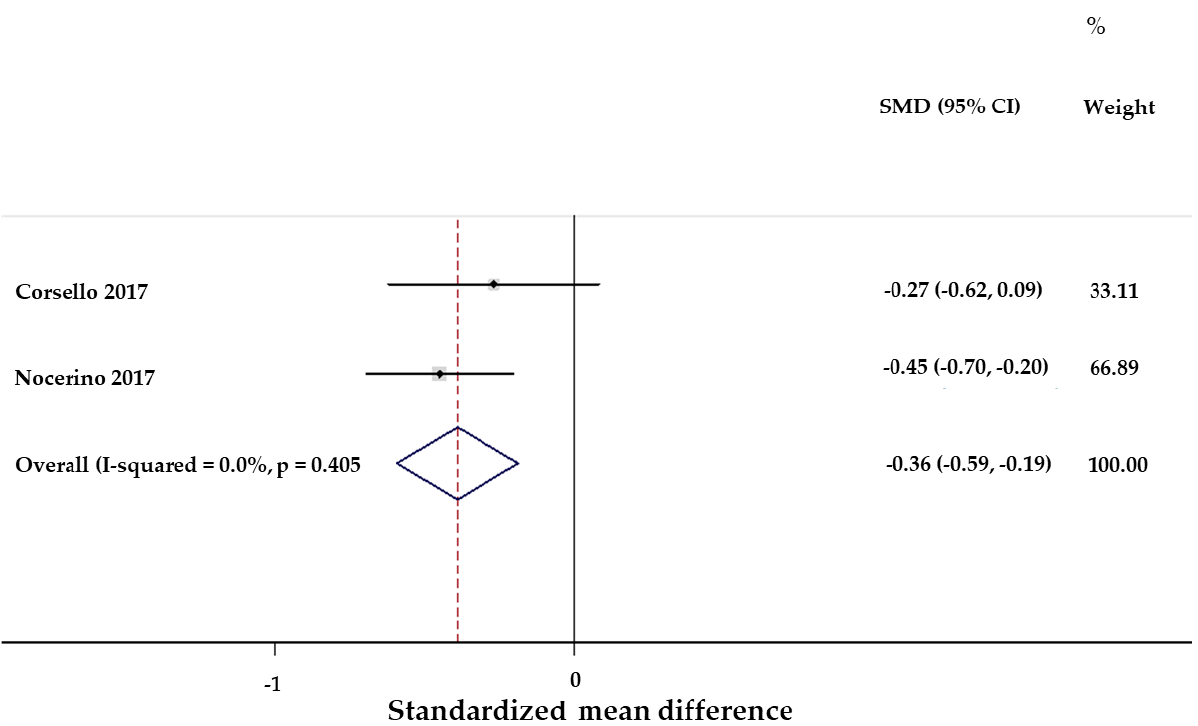
Figure 6. Protective action by FM-CBAL74 against pediatric acute gastroenteritis: forest plot of the reduction of the absolute numbers of AGE episodes reported in two randomized clinical tri- als. A meta-analysis of the raw data obtained by the corresponding author of the two randomized clinical trials was performed by applying the random-effects model. The heterogeneity between the two trials was assessed by Chi-squared and I-squared evaluation. The heterogeneity between the two studies was not significant with respect to the number of AGE episodes. Overall, when com- bining the outcome of both studies a significant impact by the dietary supplementation with the